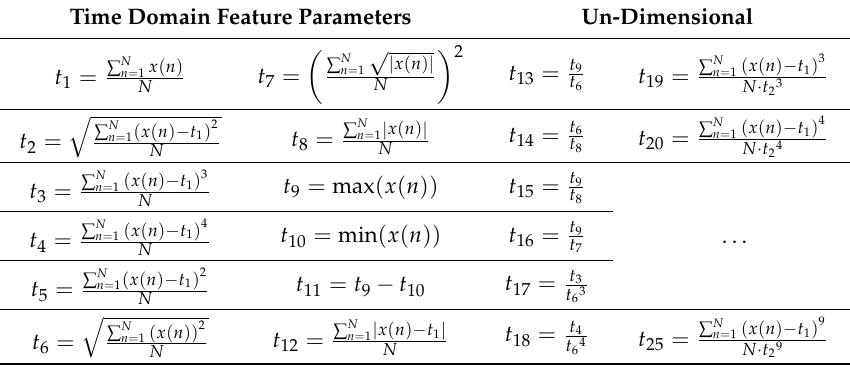
Table 1. Features in time domain.